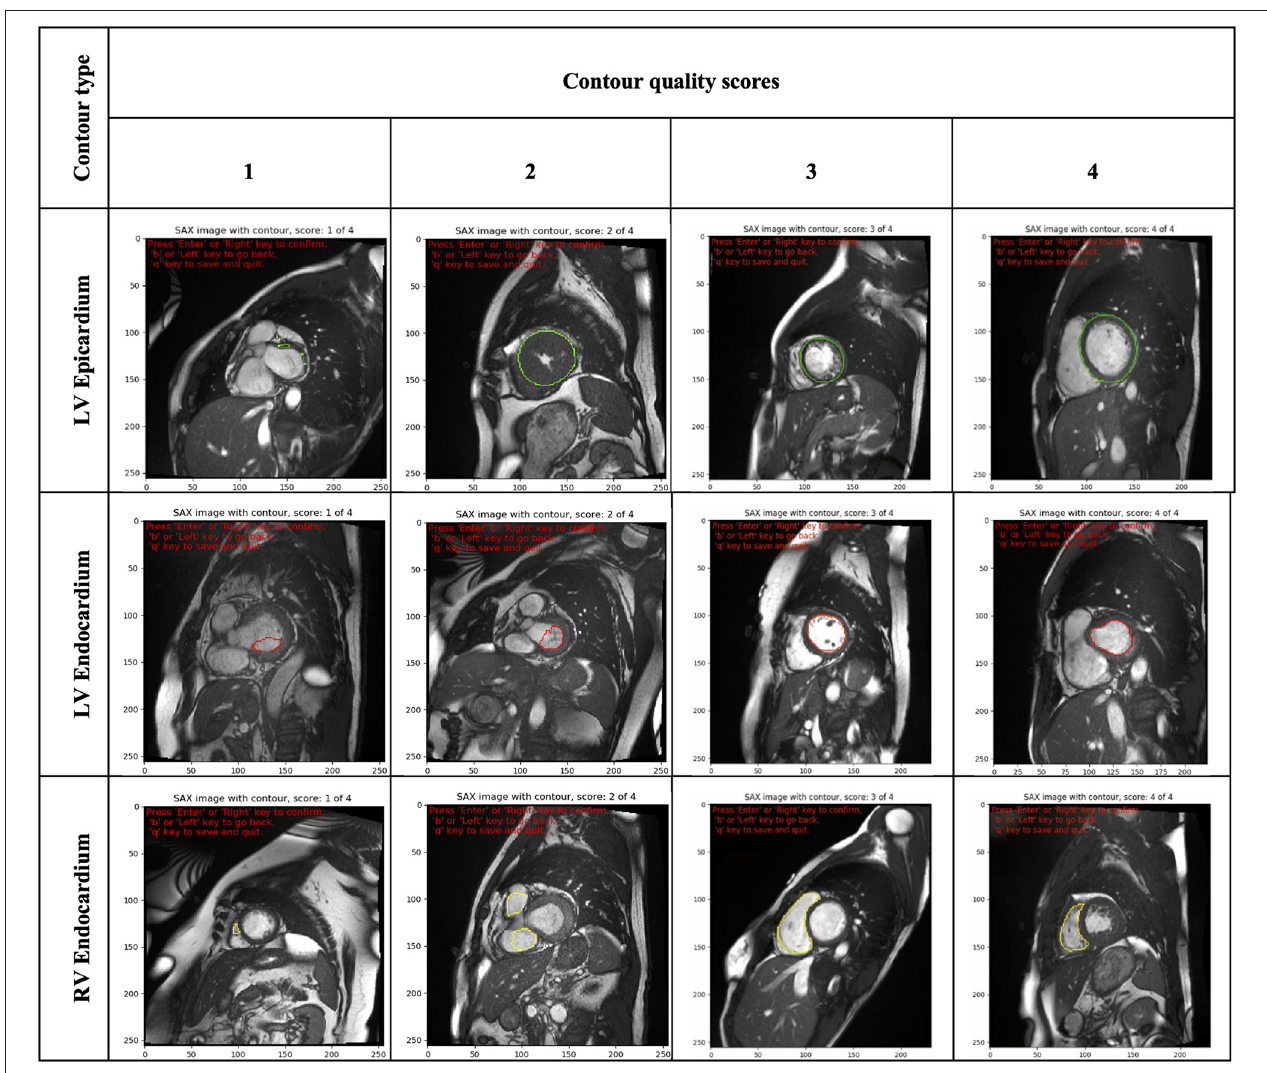
FIGURE 2 | Illustration of some contours (LV epicardial, LV endocardial and RV endocardial) showing the range of quality scores (from 1 to 4). LV, left ventricle; RV, right ventricle.